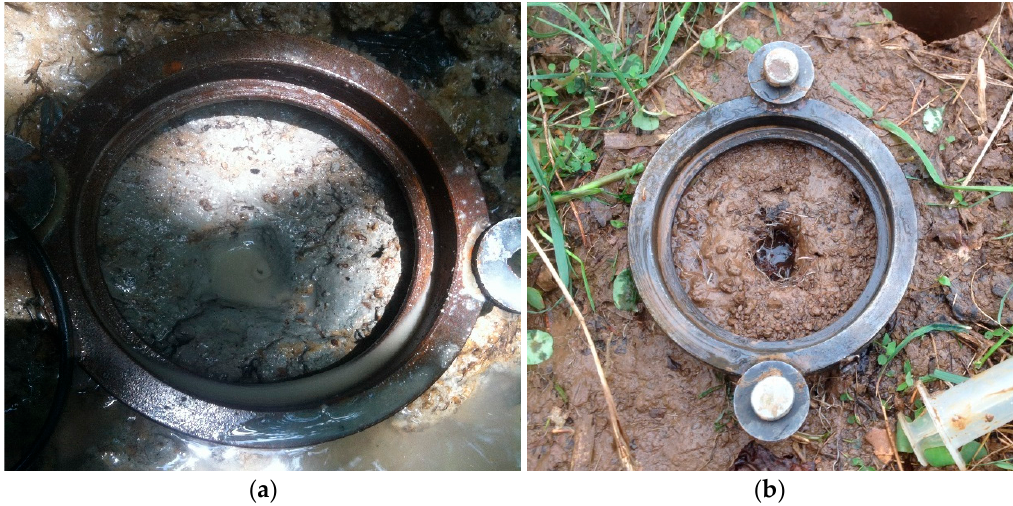
Figure 11. Photos of scour hole formation in different soil physical conditions ( a ) wide and shallower, and ( b ) narrow and deeper.